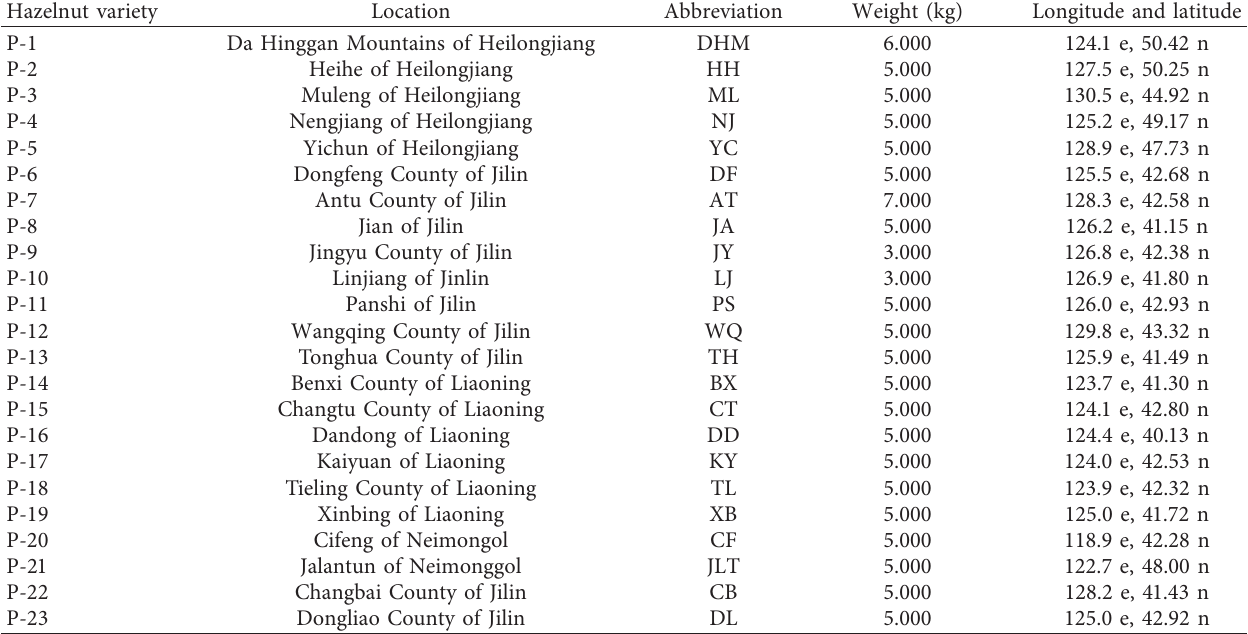
Figure 1: Wild hazelnut tree and fruits of C. heterophylla ; distribution map of hazelnuts collected from the northeast region (Jilin, Liaoning, Heilongjiang, and Neimongol) of Table 1: The collection location, abbreviation, and weight of 23 wild C. heterophylla samples tested in this study. Hazelnut variety